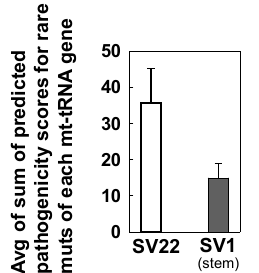
Figure 7. Predicted pathogenicity of rare unique mutations of mt-tRNAs. Predicted pathogenicity scores of rare mutations in mt-tRNAs were obtained using MitoTIP and then were totaled for each region of tRNAs. Only the mutations present exclusively in each sample (mt-tRNA mutations present only in SV22 cells vs. mt-tRNA mutations present only in SV1 cells) were included. The sums of predicted pathogenicity scores from each mt-tRNA region were averaged. Error bars represent the standard error of the mean (SEM).